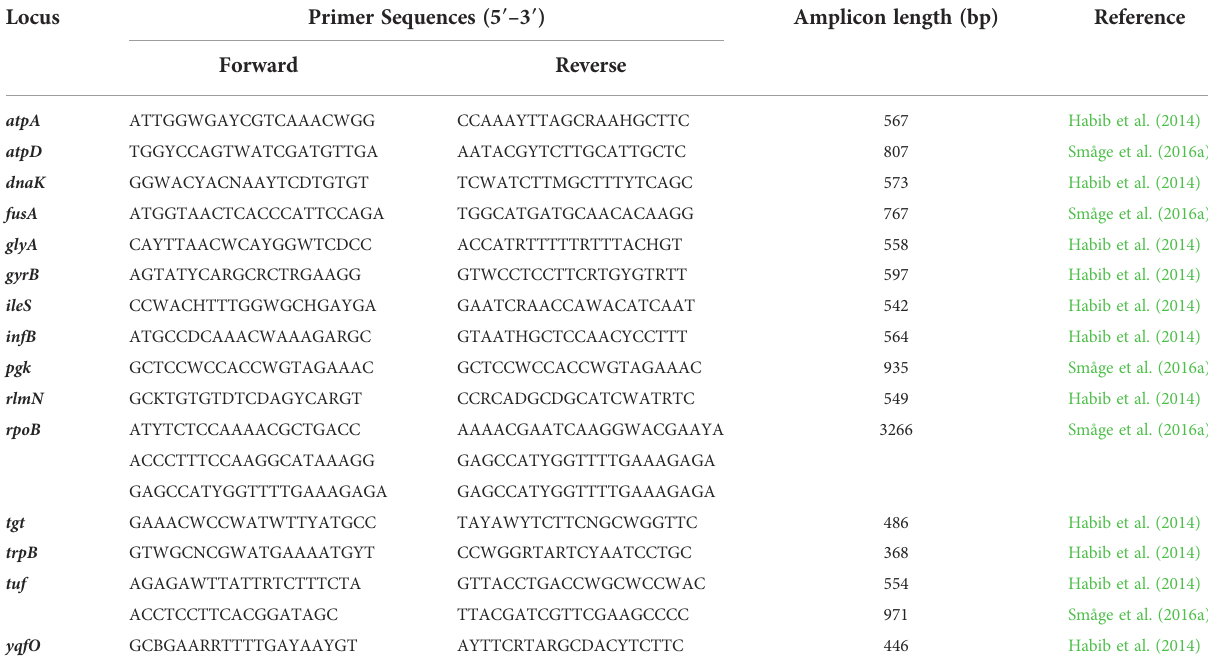
TABLE 4 Primer sets used for PCR analysis of Tenacibaculum species loci proposed in the MLST. Locus Primer Sequences (5 ′ – 3 ′